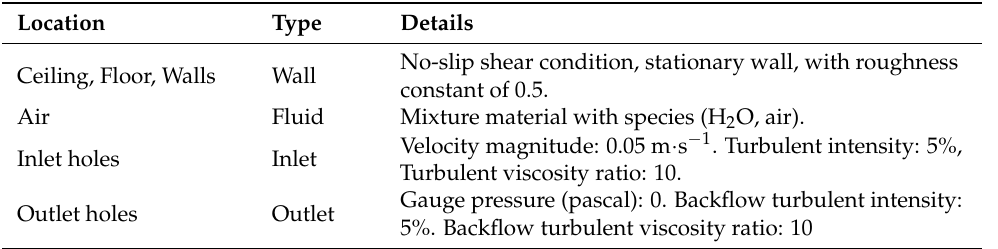
Table 5. Setup details of CFD